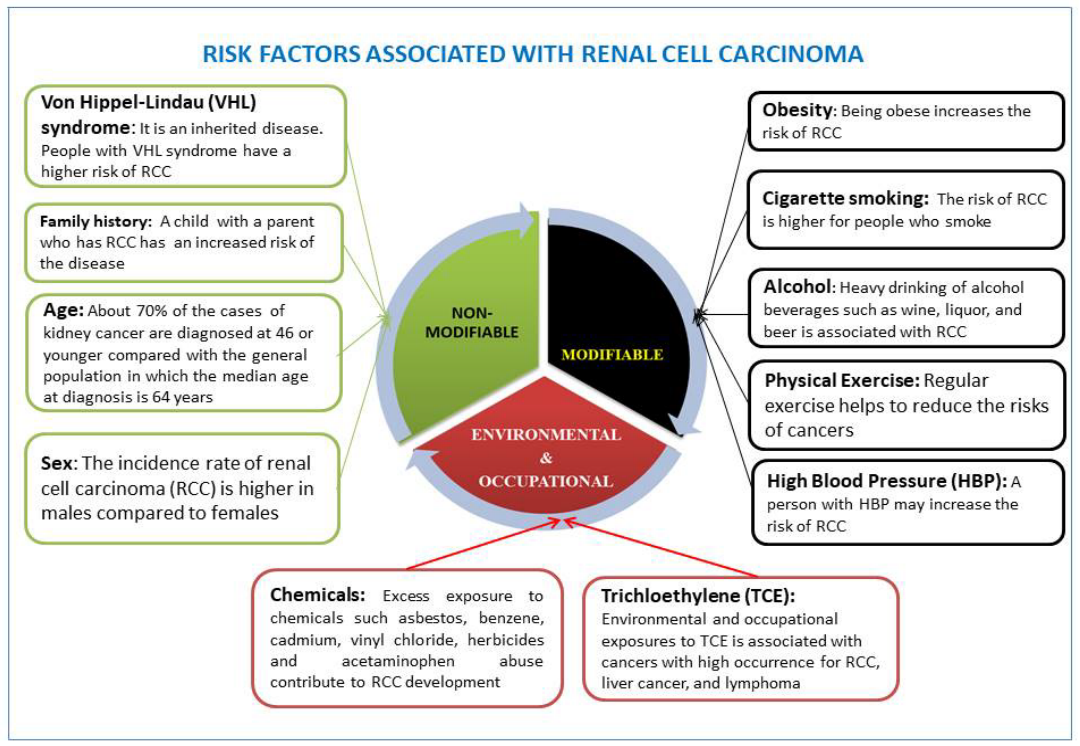
Figure 1. Leading risk factors affecting renal cell carcinoma (RCC) development are well recognized. These include nonmodifiable, modifiable (health behavioral and lifestyle), environmental, and occupational risk factors.